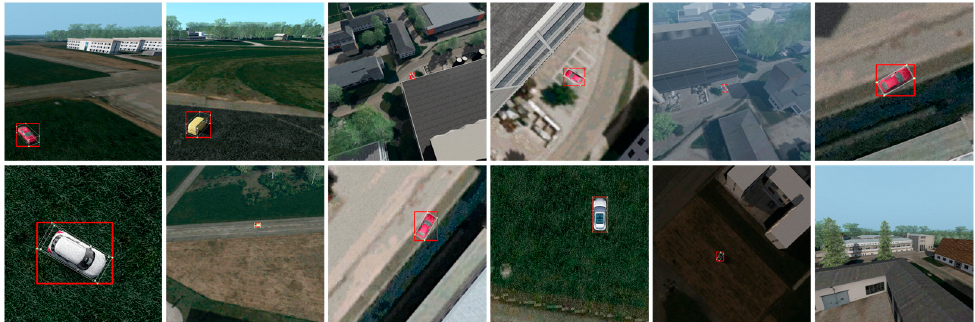
Figure 3. Schematic representation of the synthetic training data generation process. The effects and the discrete or continuous gradations of the parameter values are shown. The result is a synthetic training dataset with rendered images and the respective annotation files.